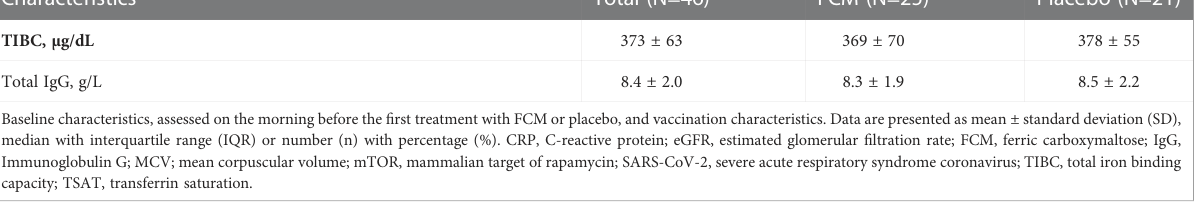
[Figure 3E]), plasma ferritin (Spearman ’ s rho 0.00, P =0.98), plasma iron (Spearman ’ s rho 0.11, P =0.45, Figure 3F) or total